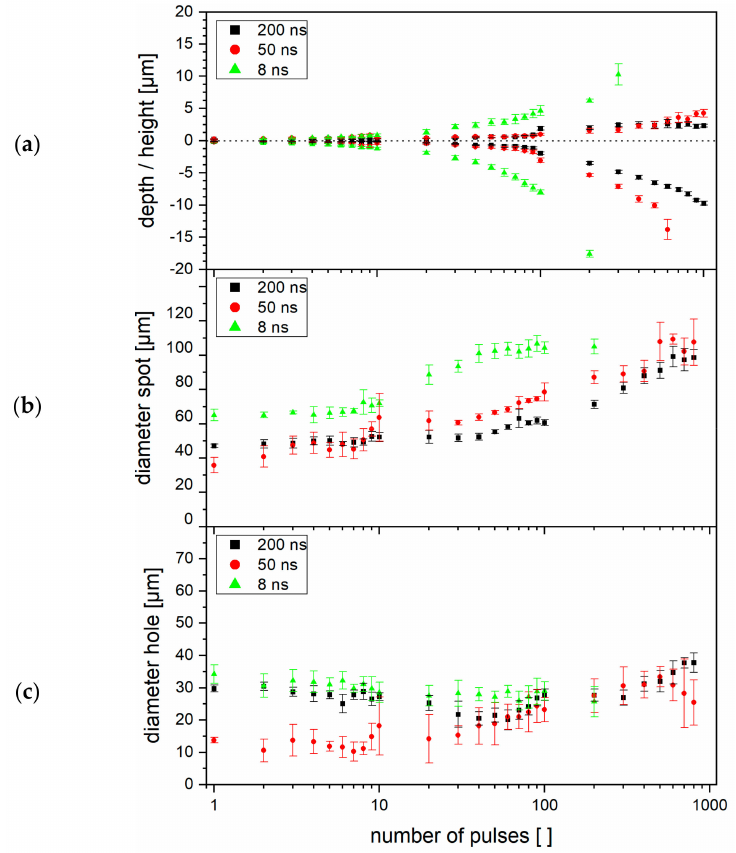
Figure 4. ( a ) Measured structure depth and height relative to the untreated surface, ( b ) spot diameter and ( c ) hole diameter for DLW processed holes on stainless steel according to the definition in Figure 3c. The error bars represent the standard deviation of 8 measured spots.